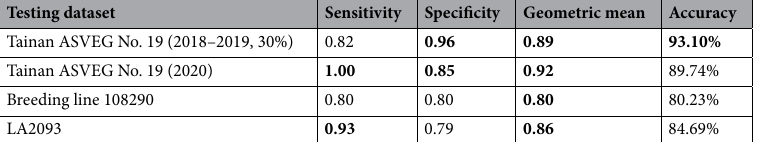
Table 3. Performance of model validation for binary logistic model. Values that meet acceptable standards are shown in bold.